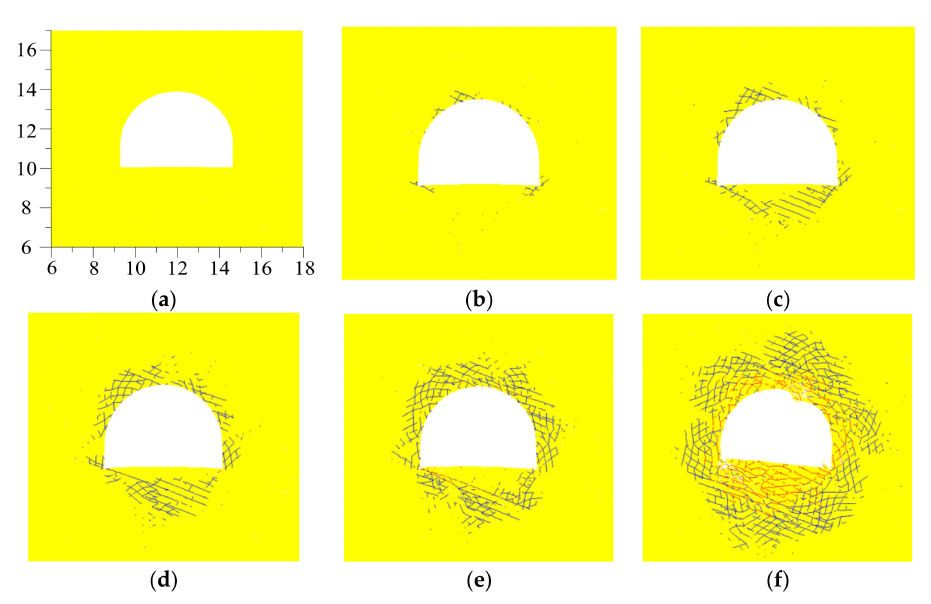
Figure 15. Development of shear and tension cracks in the roadway surrounding rock during the excavation unloading process: ( a ) unloading stage 1; ( b ) unloading stage 6; ( c ) unloading stage 7;